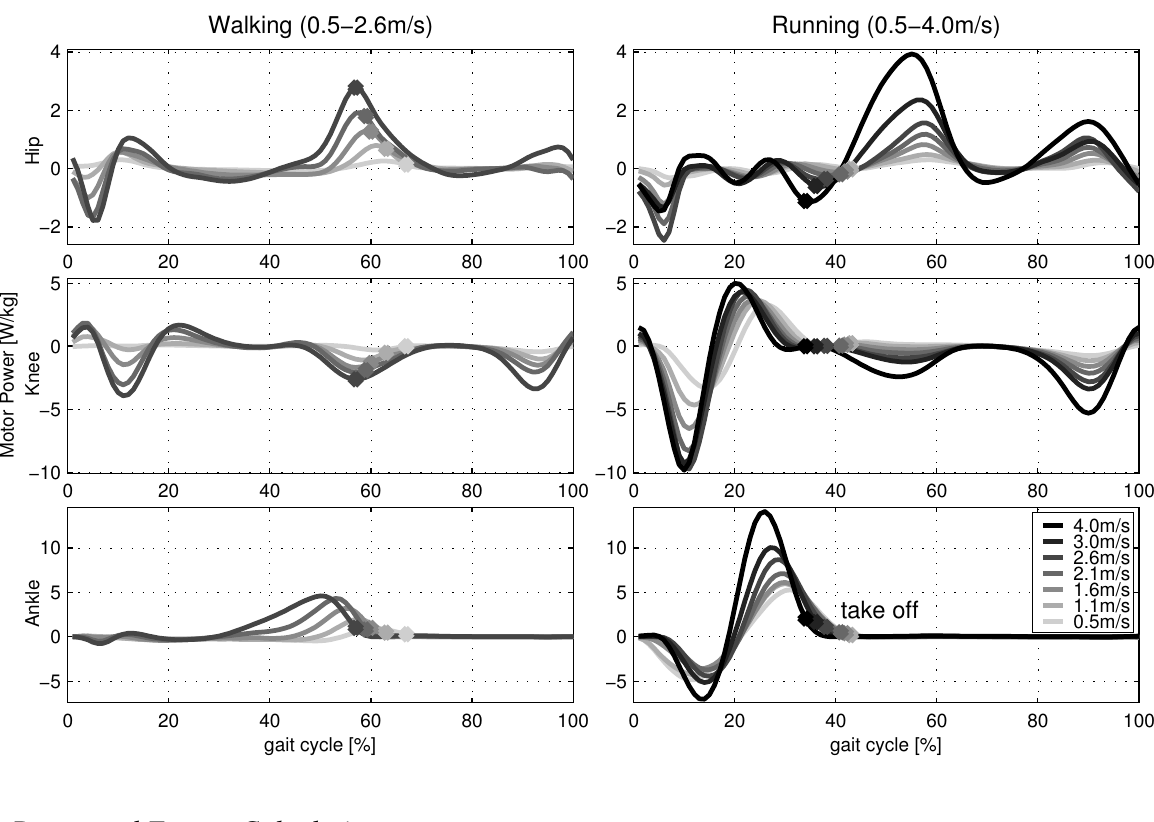
Figure 2. Hip, knee and ankle joint power for a cycle of human walking and running (mean of all subjects). The light grey line represents lower speeds starting at 0.5 m/s. The black line represents maximum speed of 4 m/s (only running). The measured joint power is similar to the power necessary for a direct drive system to mimic the torque angle profile of each joint. These curves were used as a reference for calculating possible reductions in energy and peak power when using an series elastic actuator